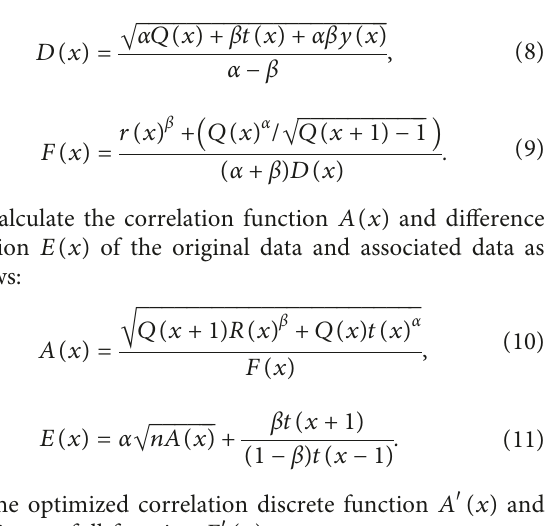
Figure 8: Experimental results of controllable analysis and evaluation of college students’ mental